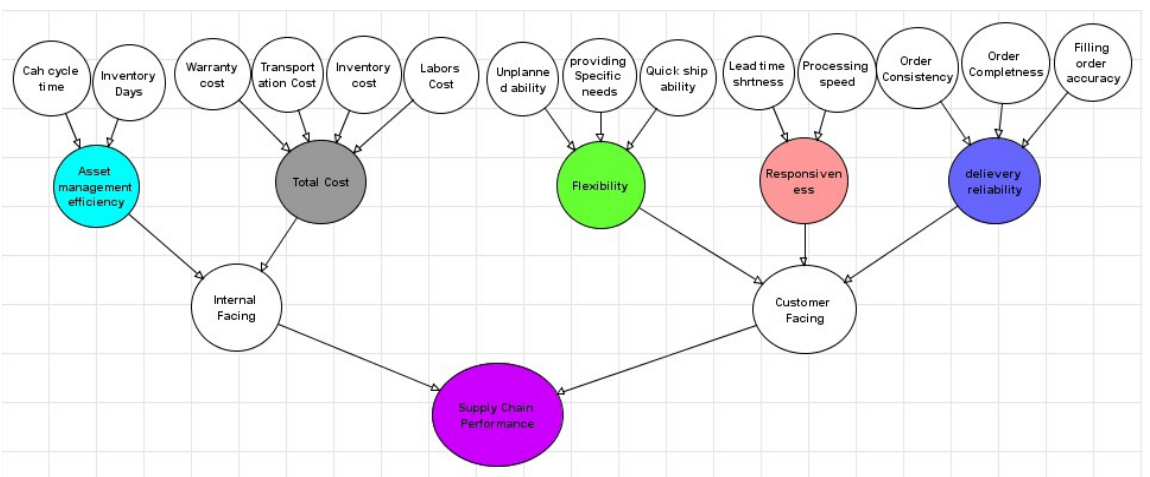
Figure 1. BN model of supply chain